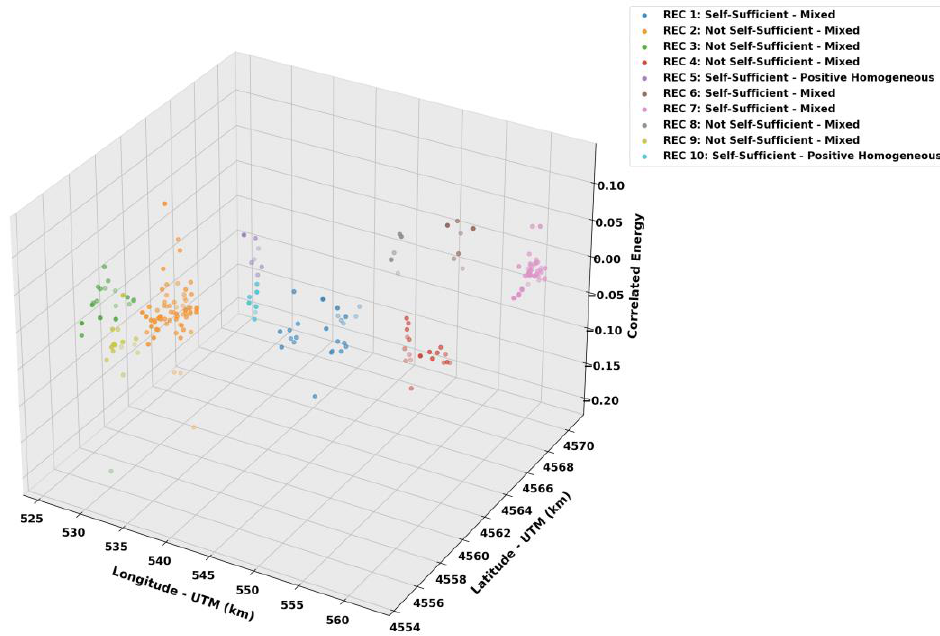
Figure 18. Members distributed by REC—complete-link.